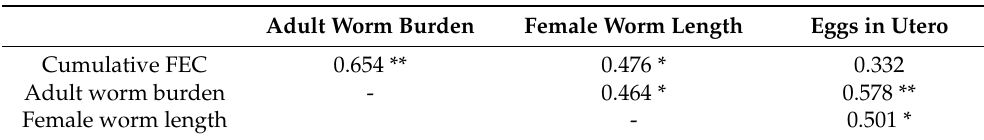
Table 2. Parasitological correlations in three-month-old sheep after trickle infection with Teladorsagia circumcincta L3.